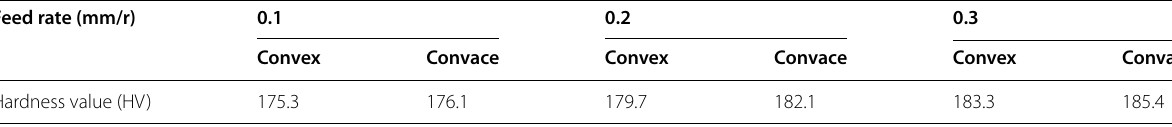
Table 7 Microhardness variation of machined surfaces with cutting speed Cutting speed (m/min) 170 200 Convex Convace Hardness value (HV) 179.3